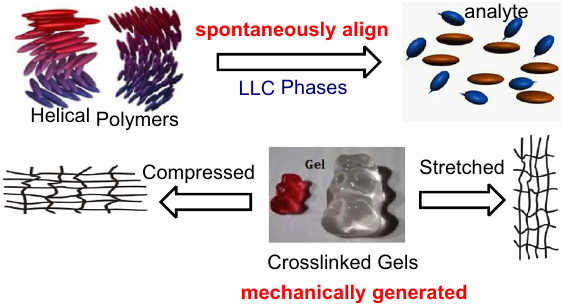
Fig. 2 The diagram of two alignment media for RDCs